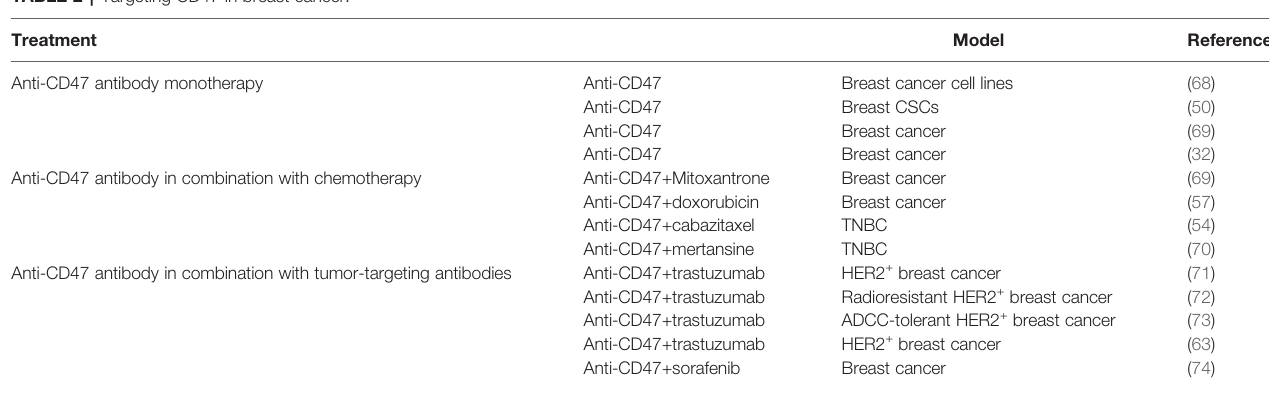
TABLE 2 | Targeting CD47 in breast